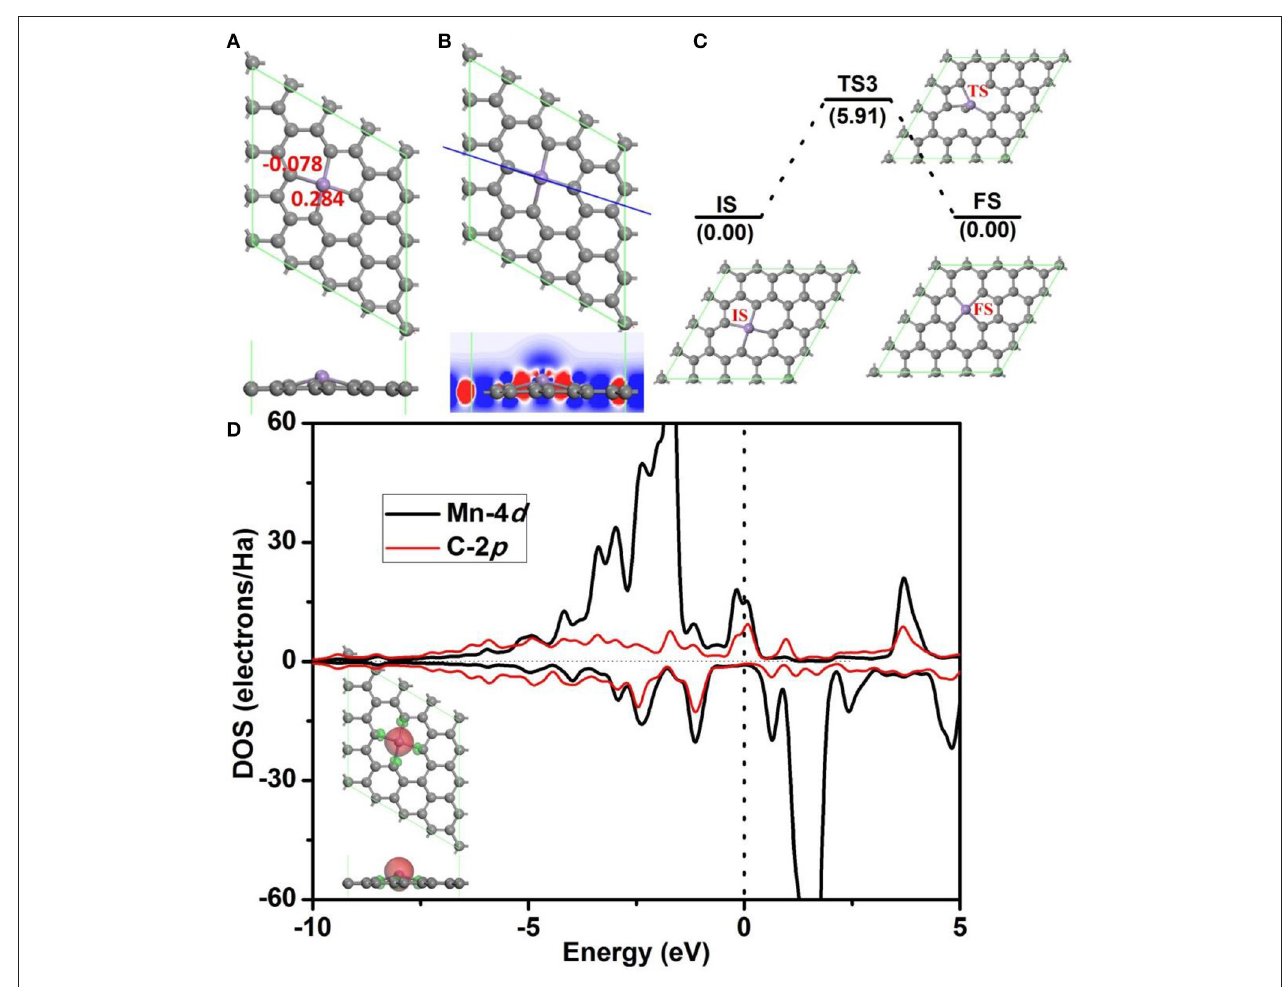
FIGURE 2 | (A) The atomic structure of divacancy graphene embedded with Mn atom (Mn-DG), where the gray and pink atoms are C and Mn atoms, respectively, in this and following figures. The atomic charge obtained by Hirshfeld analysis near the Mn dopant is also given. (B) The differential charge density along C-Mn-C bonds for Mn-DG is shown, where the blue and red isosurfaces correspond to the increase in the number of electrons and the depletion zone, respectively. (C) The diffusion pathway of the Mn atom on Mn-DG, where IS, TS, and FS represent initial, transition and final structures, respectively, in this and following figures. (D) PDOS of Mn atom and C atom on the Mn-DG, where the vertical line indicates the Fermi level. Inset is the positive and negative spin density of Mn-DG shown in green and red,